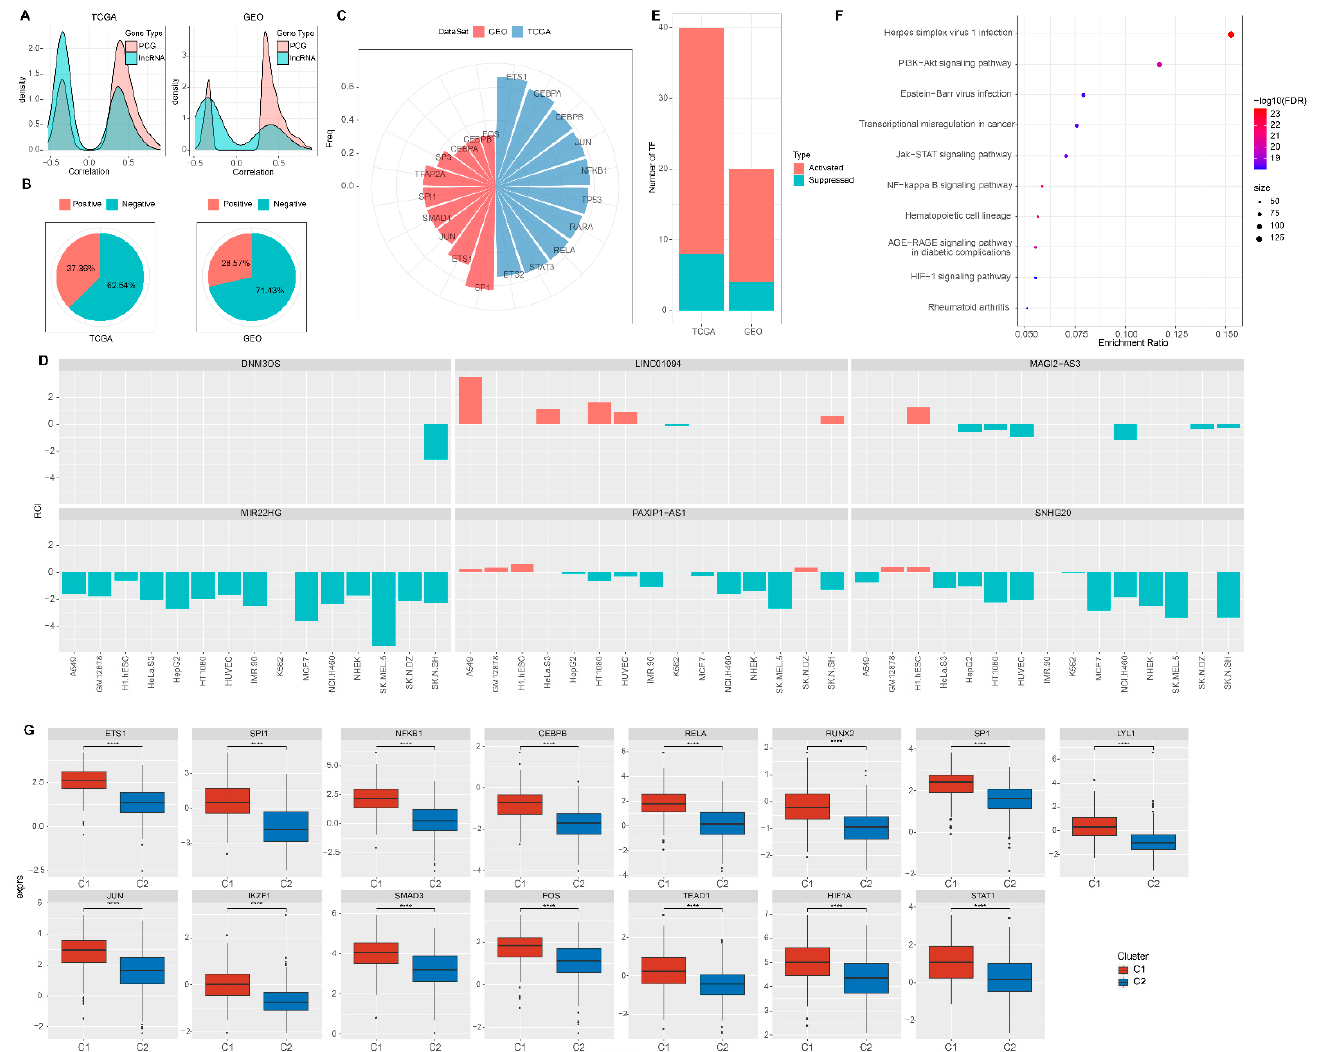
Figure 7. Characteristic analysis of EMT-associated lncRNAs. ( A ) Correlation coefficient density curve of EMT-associated lncRNAs and protein-coding gene (PCG). ( B ) Definition of EMT-associated lncRNAs in cells, where negative was RCI < 0 and positive was RCI > 0. ( C ) Distribution of TF significantly negatively correlated with nuclear lncRNAs in the two cohorts. ( D ) Distribution of lncRNAs in cells consistent with EMT activity in the two LSCC. ( F ) Distribution of activated and inhibited TF in the C1 subtype compared with the C2 subtype. ( G ) Functional enrichment analysis of uniformly upregulated TF in the C1 subtype. ( E ) Distribution of uniformly upregulated TF in TCGA subtypes. Ns; p > 0.05; **** p < 0.0001.